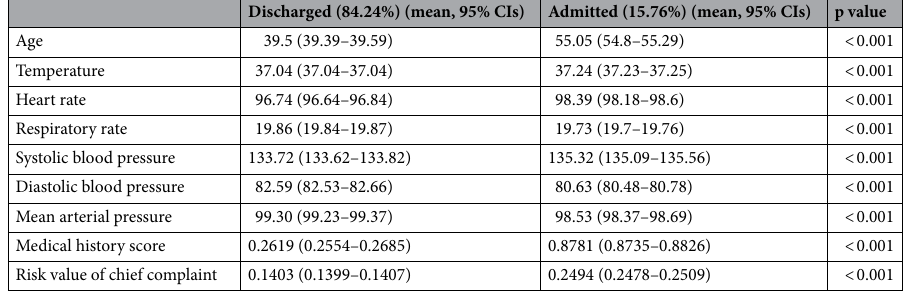
Table 2. Characteristics concerning age, triage evaluation, and risk value of chief complaint for all study samples. CIs confidence